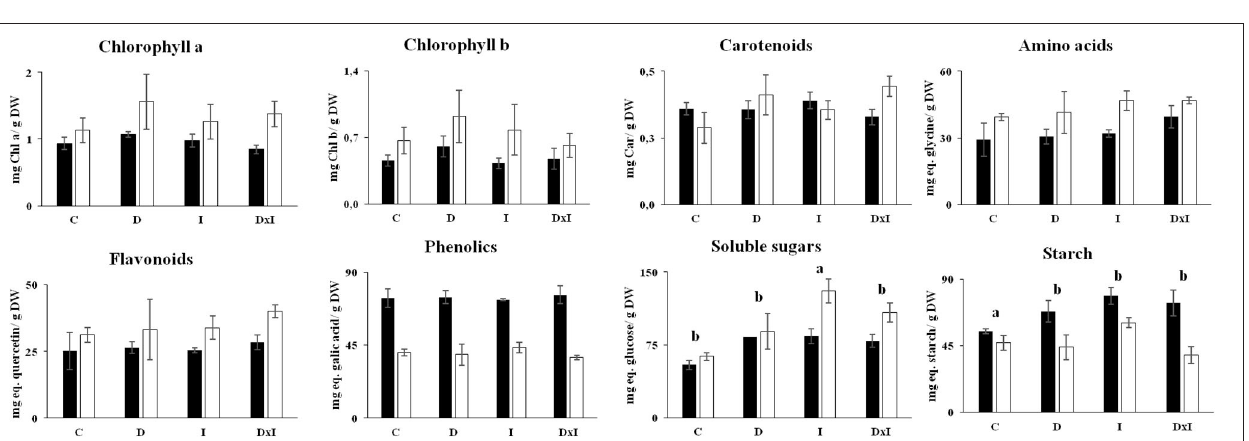
FIGURE 5 | Contents in photosynthetic pigments (chlorophyll a, chlorophyll b, and carotenoids) and metabolites (amino acids, flavonoids, phenolics, soluble sugars, and starch) in leaves of Q. ilex seedlings from the Seville (white bars) and Almeria populations (black bars). Values are mean ± SE of three biological replicates on day 32. Different letters denote significant differences among treatments ( p <